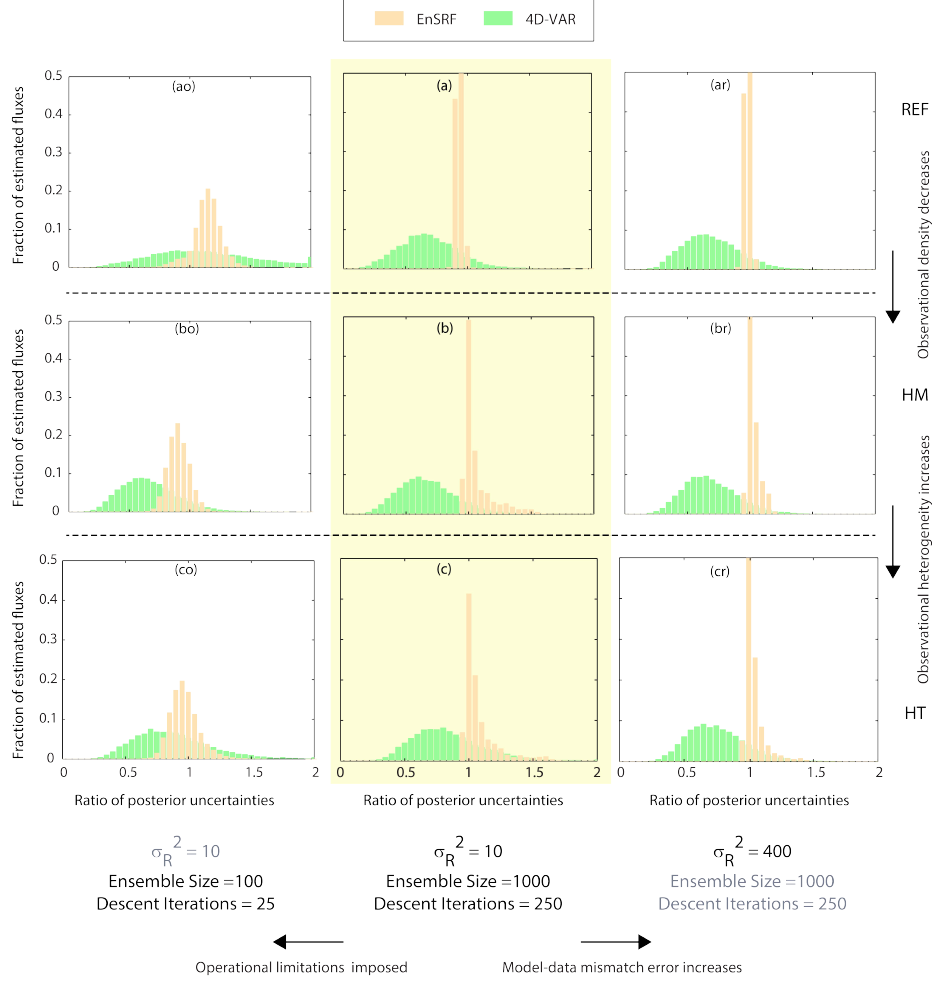
Fig. 5. Histogram showing the ratio of the estimated posterior uncertainties from the EnSRF ( σ ˆ s ) and the 4D-VAR ( σ ˆ s ) approaches EnSRF 4D - VAR to the posterior uncertainties from the BIM ( σ ˆ s ) approach. The ratios are calculated for each estimated flux time/location over all 30 time BIM periods to be representative of the overall experiments outlined in Table 1. In the ideal case – that is, if the posterior uncertainty from a DA approach is equal to the posterior uncertainty from BIM – the histogram would be a single line centered around